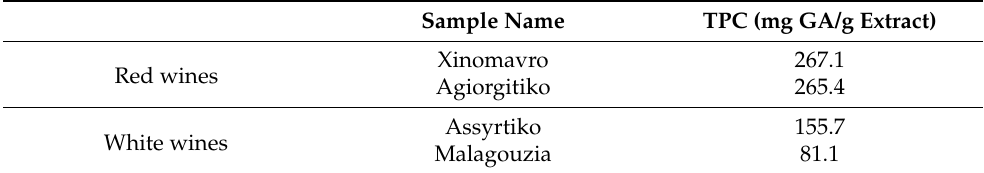
Table 2. Total Polyphenolic Content (TPC) of different wine varieties.